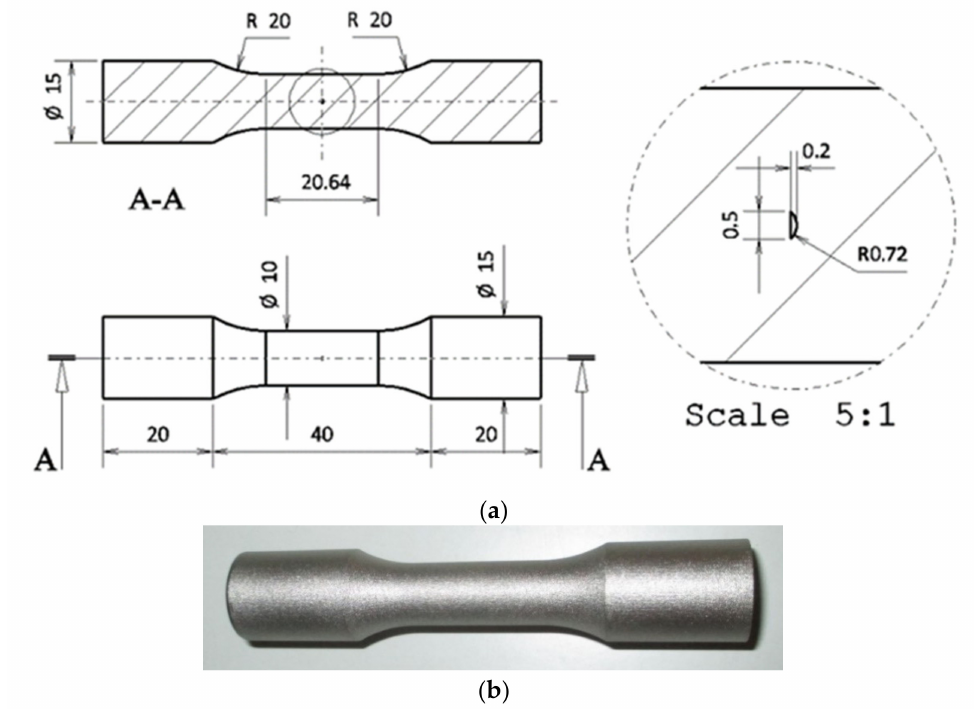
where two phases of material are identified with a martensitic phase α (in the form of black needles) due to the fast solidification and columnar phase β represented by the grey areas. Only a small amount of internal micro pores was observed.